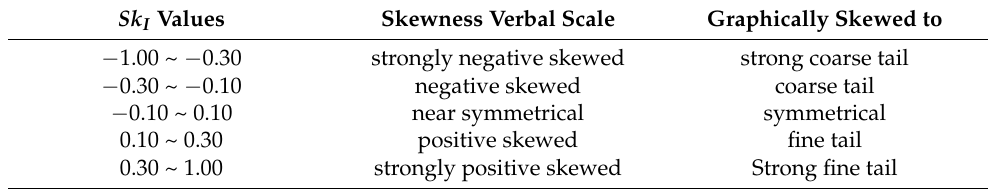
Table 2. Classification scale for